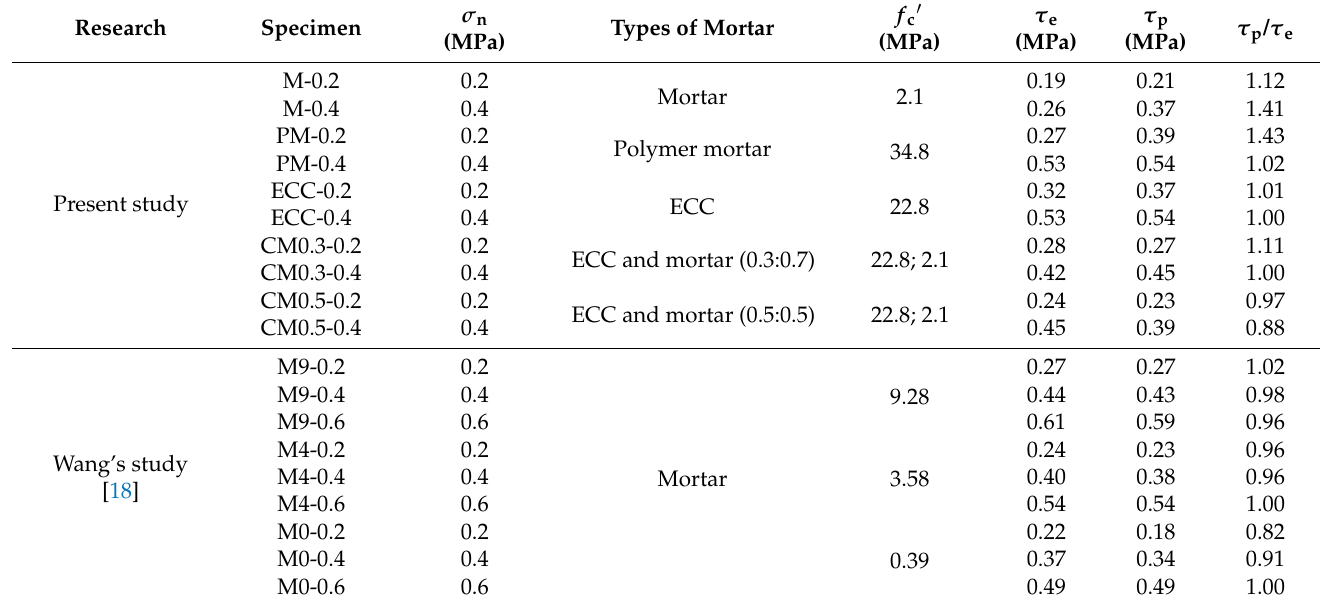
Table 5. Experimental and predicted results of shear